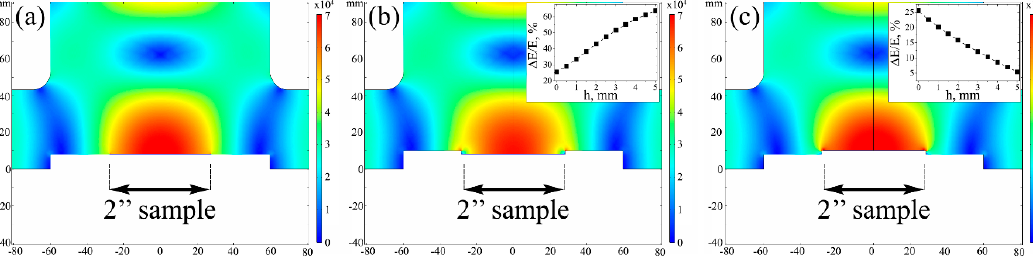
Figure 2. E-field calculations for the chamber of ARDIS-100 reactor with different geometries of the substrate holder: ( a ) flat holder, ( b ) pocket-holder, and ( c ) pedestal holder. Insets in ( b , c ) show calculated electric field nonuniformity plotted as a function of height h in pocket and pedestal designs,